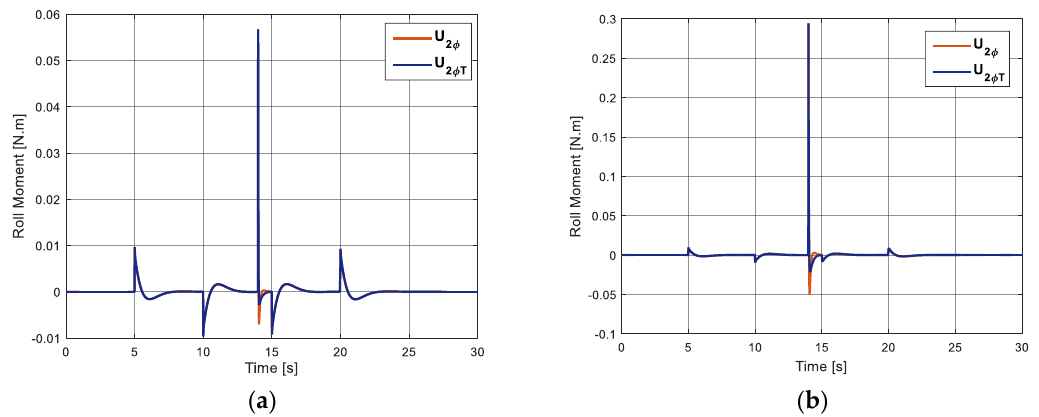
Figure 5. Comparison of Control torque between NASMC and MASMC: ( a ) 10% LoCE in actuator 2; ( b ) 50% LoCE in actuator 2.